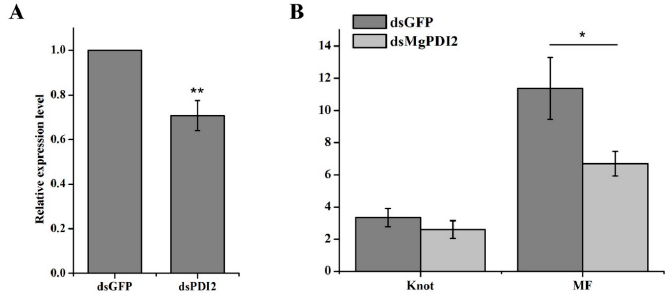
Figure 5. E ff ect of MgPDI2 expression on rice susceptibility to M. graminicola infection. ( A ) MgPDI2 expression in nematode after treatment with dsRNA targeting MgPDI2 . Asterisks indicate significant di ff erences based on Tukey’s test (*: p < 0.05; **: p < 0.01). ( B ) Average numbers of knots and the MF values at 15 dpi.